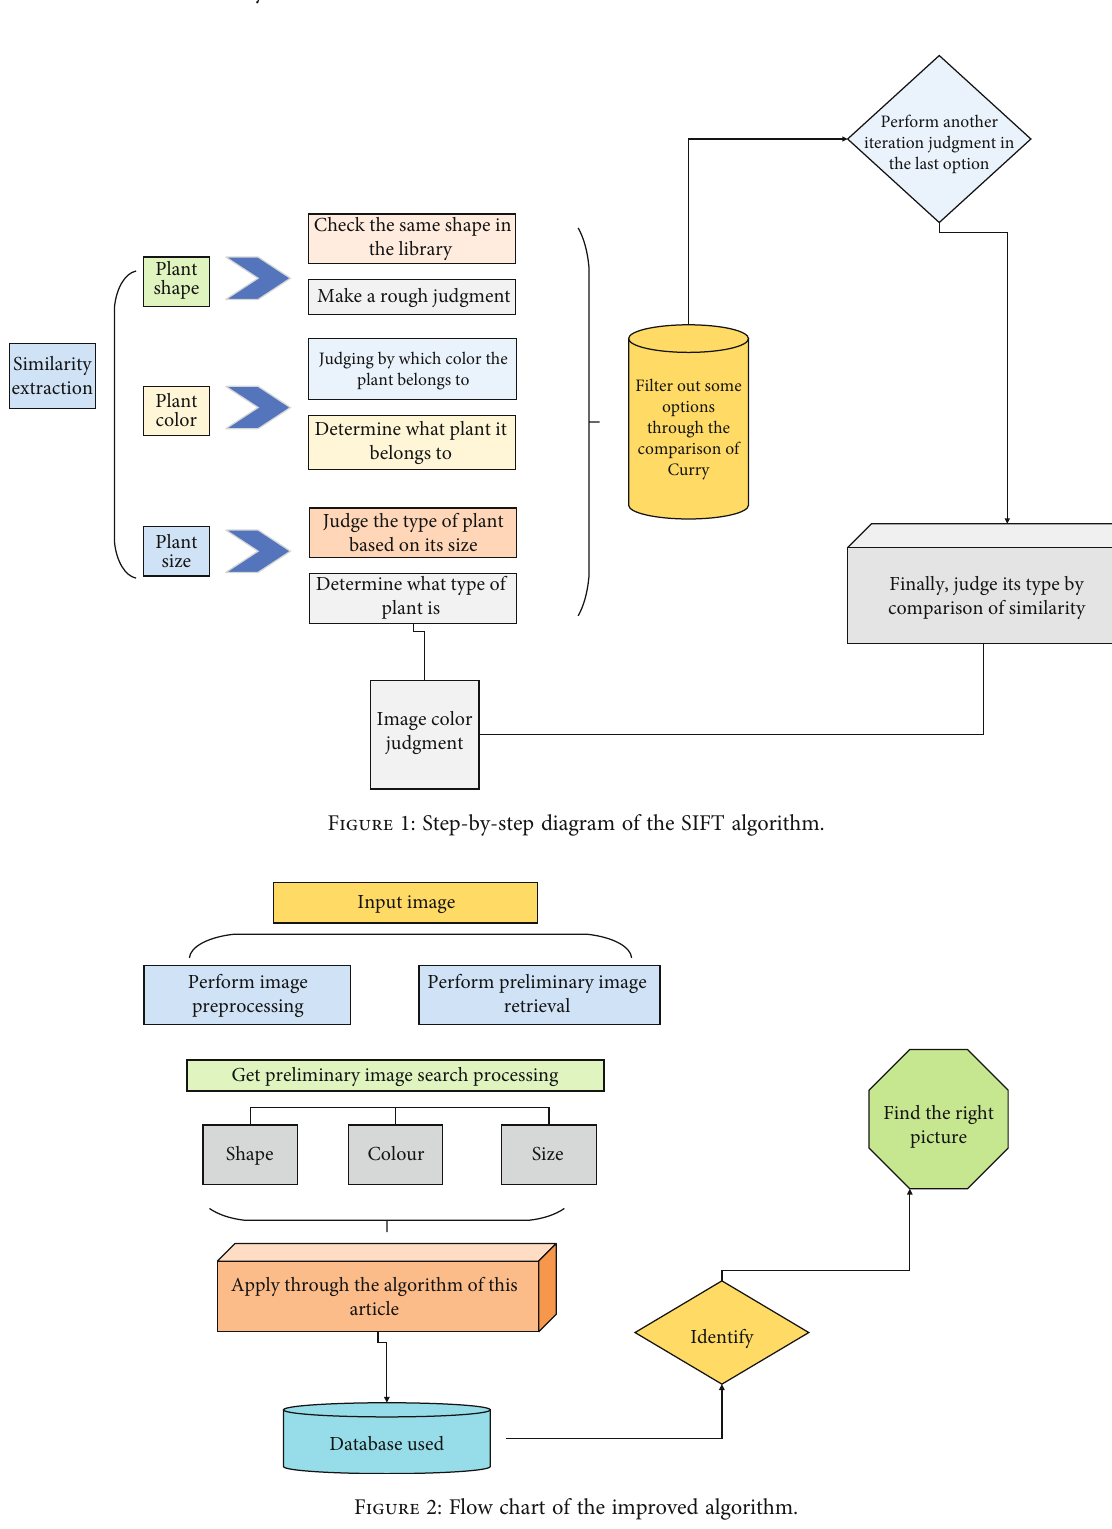
Figure 2: Flow chart of the improved